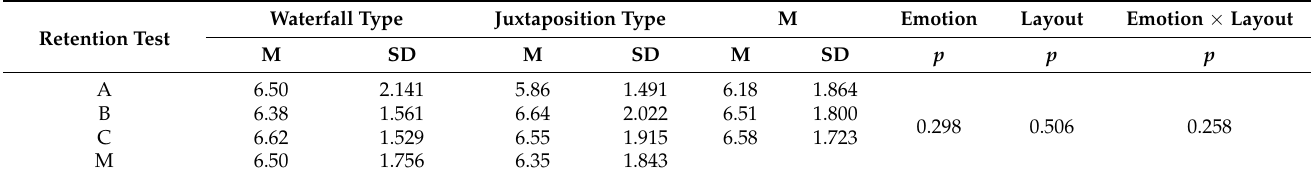
Table 2. Descriptive statistics and two-way ANOVA of the retention